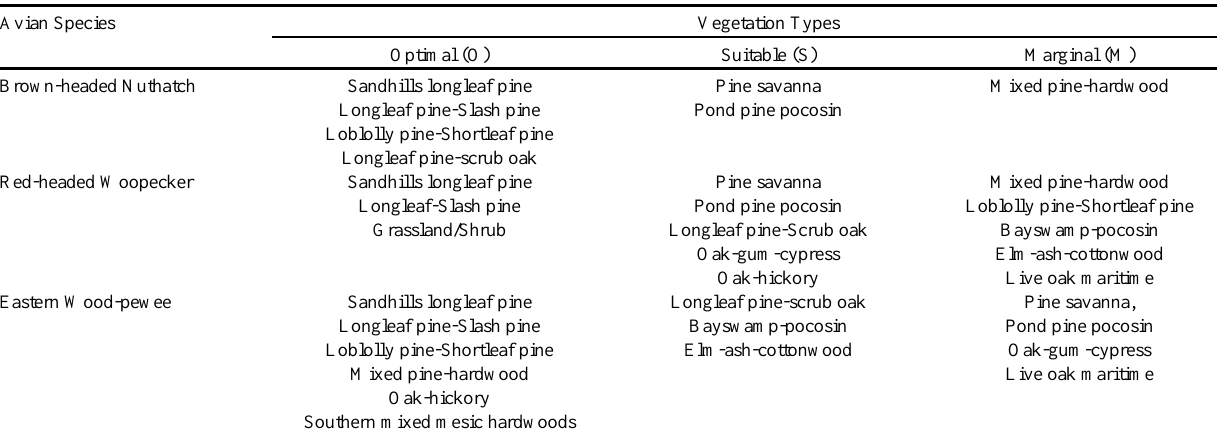
Table 1 . Vegetation types ranked by their suitability for three avian species in the South Atlantic Coastal Plain, United States, based on expert knowledge (Hamel 1992). Candidate model sets were evaluated with single-season occupancy models. The purported strength between occupancy probability and Hamel’s habitat suitability categories was: optimal (O) > suitable (S) > marginal (M). Optimal habitat for the woodpecker was defined as per Hamel (1992) and as Optimal-revised to reflect recent literature on the species (see